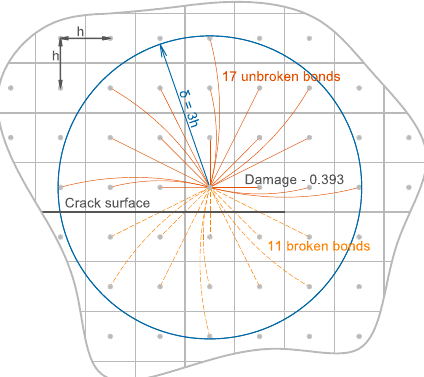
Figure 2. The most conservative two-dimensional (2D) case when it could be thought that a crack has appeared. Some bonds are drawn curved to avoid overlapping.